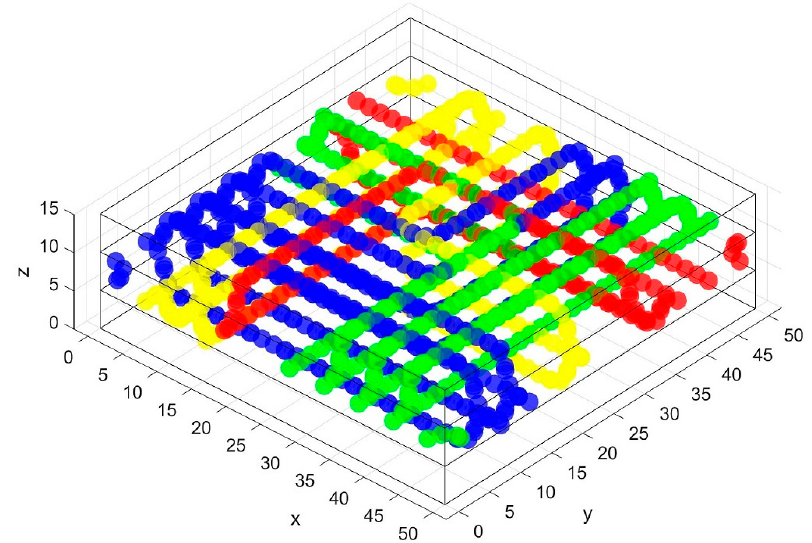
Figure 18. Sample trajectories of the selected UAVs in the simulation. One UAV is represented by one color and UAVs coming from the same way have the same color.